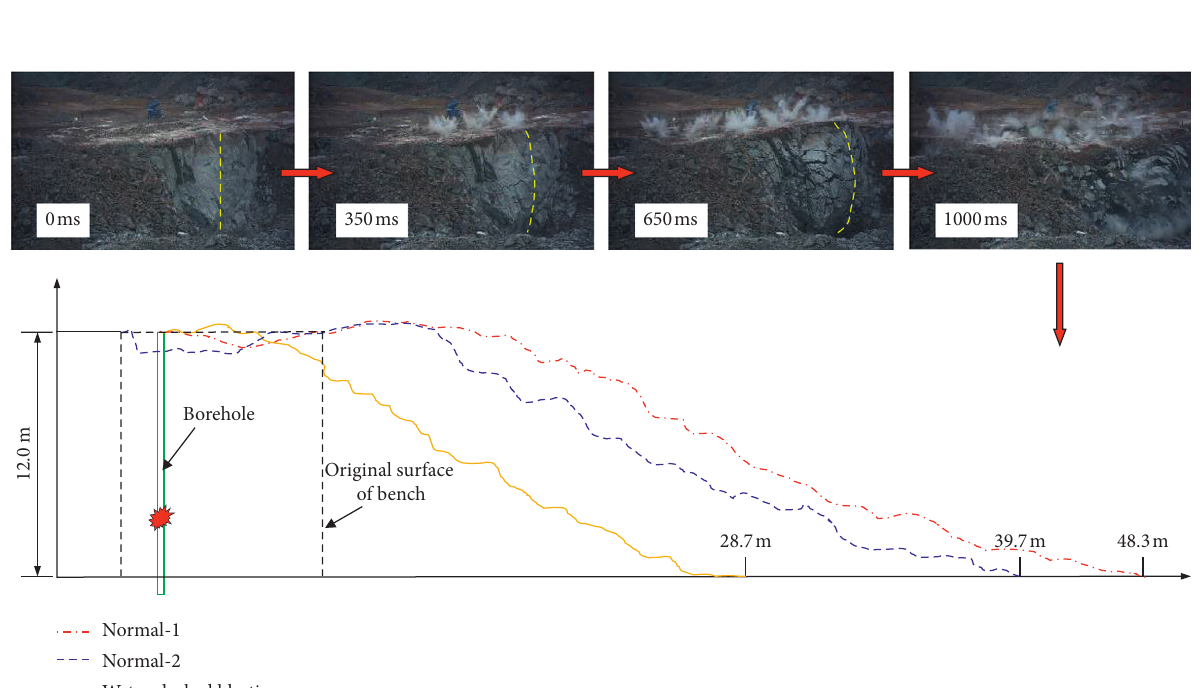
Figure 13: Throwing and accumulation of rock fragments in bench